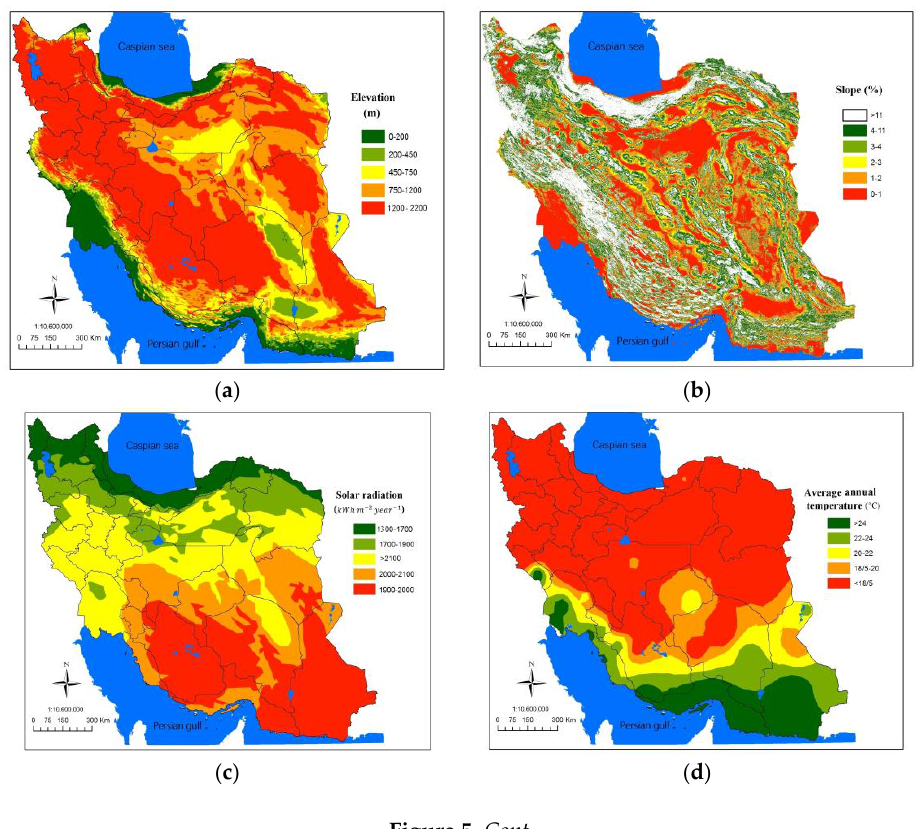
Figure 5. Cont. Figure 5.